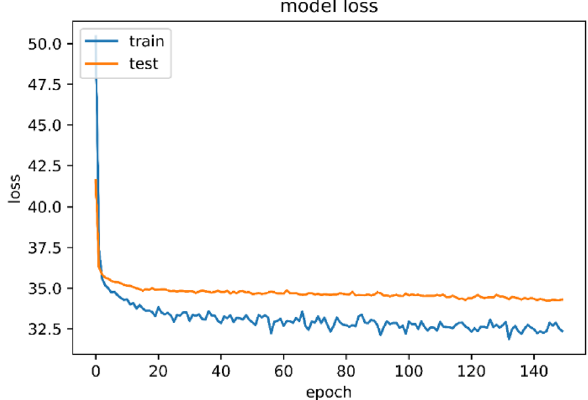
Fig. 14 Loss of the bi-directional LSTM-RNN learner 3 while predict- ing calorie